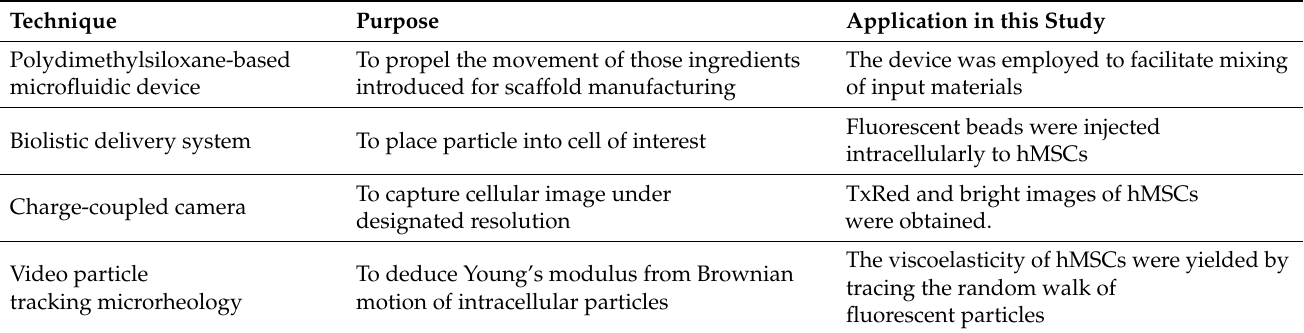
Table 1. List of the techniques utilized in the study. hMSC: human mesenchymal stem cell.